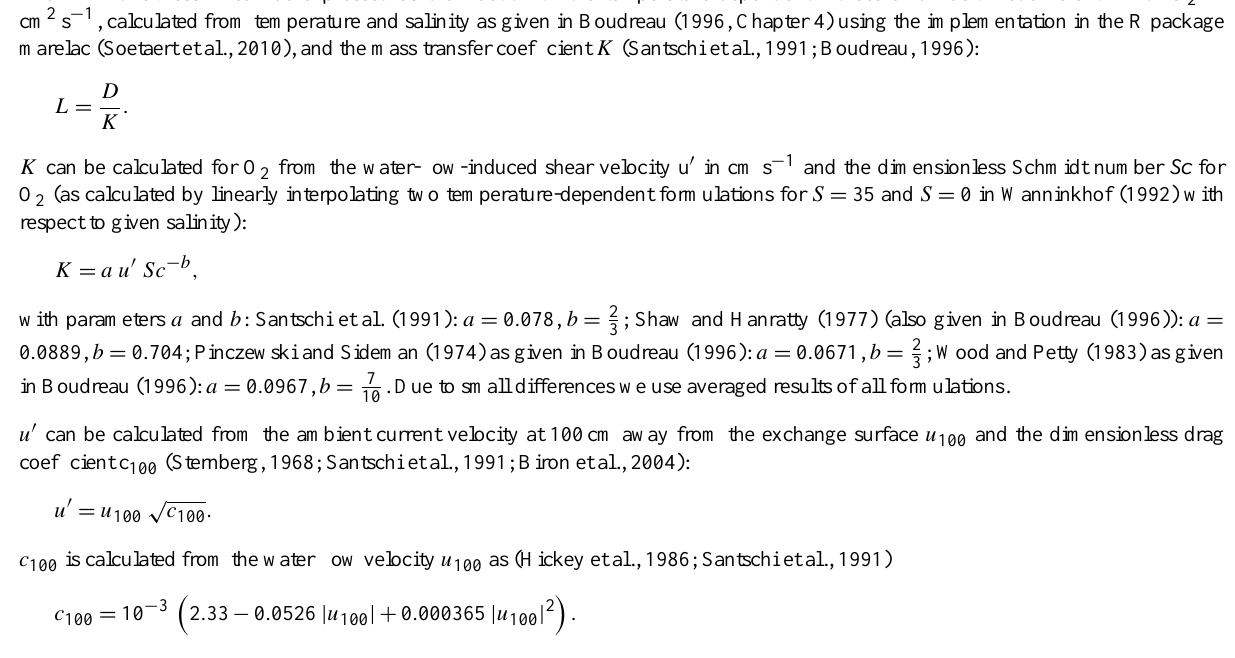
Table 2. Expressing the DBL thickness L as a function of water flow velocity: a generic planar surface description. The DBL thickness L can be expressed as the fraction of the temperature-dependent molecular diffusion coefficient D for O 2 in cm 2 s − 1 , calculated from temperature and salinity as given in Boudreau (1996, Chapter 4) using the implementation in the R package marelac (Soetaert et al., 2010), and the mass transfer coefficient K (Santschi et al., 1991; Boudreau, 1996): D L = K